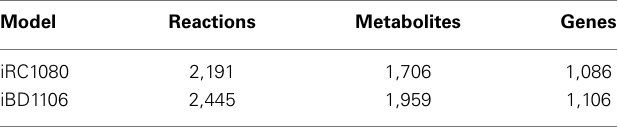
Table 2 | Contents of iRC1080 and iBD1106 .